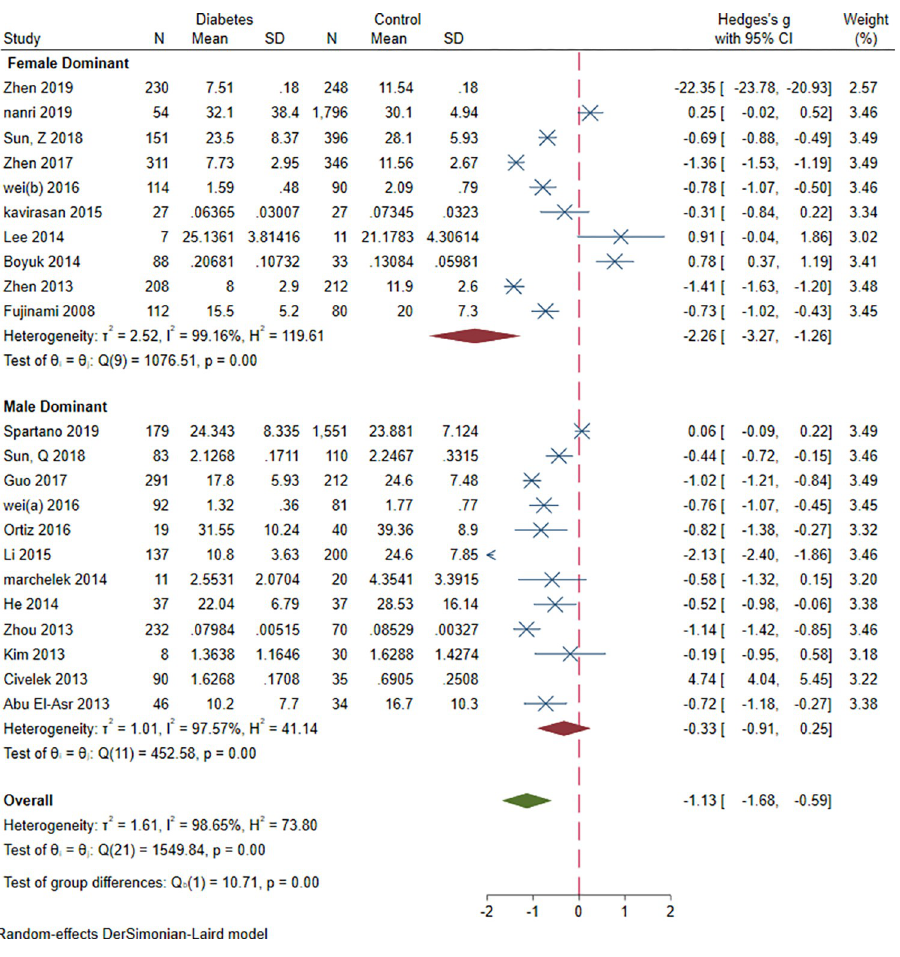
Fig 13. Subgroup meta-analysis of BDNF levels in patients with DM by gender dominance of the study population.